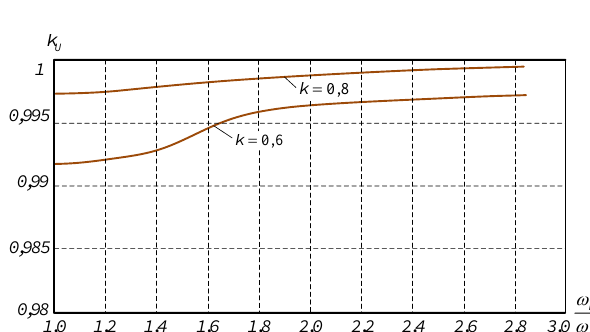
Figure 8. Functional dependence of distortion factor of output voltage on ratio of rotational speed of generator to output voltage frequency of MCVS with